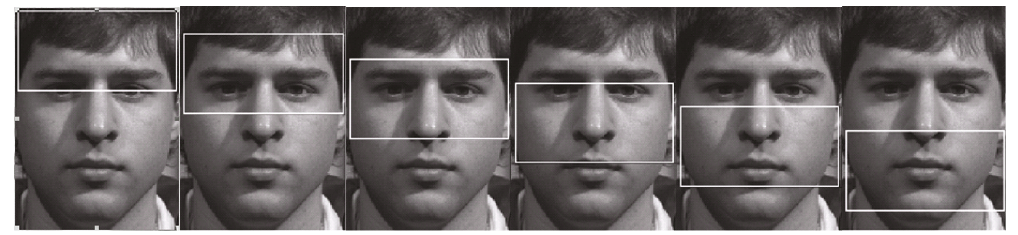
Figure 9: Example subareas from the first step of searching.